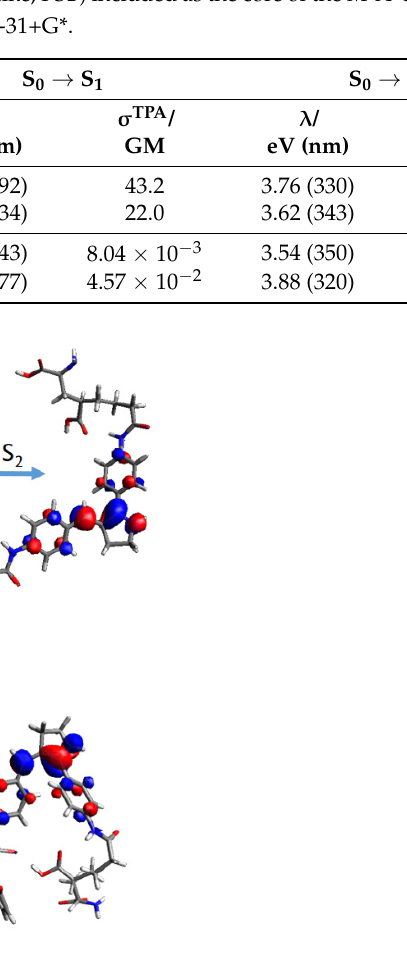
Figure 8. ( a ) Maleimide-protonated Schiff base-glutamate (M-PSB-G) structure; ( b ) E isomer and ( c ) Z isomer molecular orbitals involved in the S 0 → S 2 electronic transition. ( c ) Z isomer molecular orbitals involved in the S